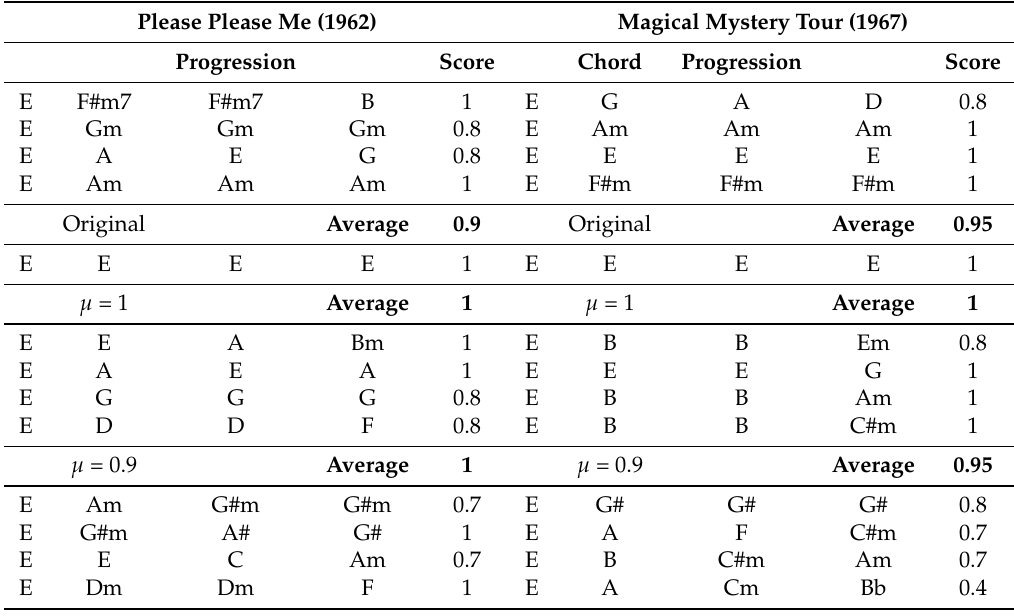
Table 3. New chord progressions—transformational